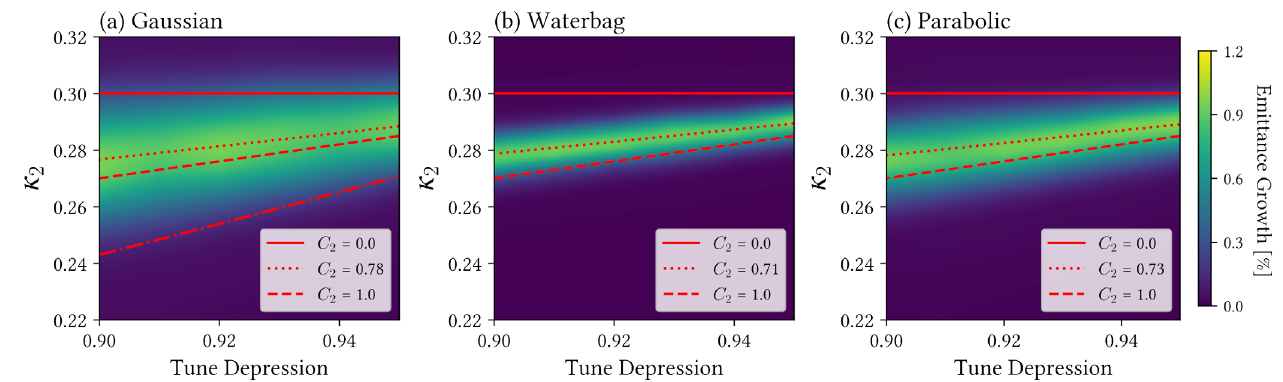
FIG. 12. Emittance-growth chart obtained from W ARP simulations with the quadrupole driving perturbation on. Three different types of initial particle distributions, i.e., (a) Gaussian, (b) waterbag, and (c) parabolic, are considered, all of which are well matched to the sinusoidal focusing potential. The Gaussian tail has been truncated by one percent in four-dimensional phase space. The bare betatron tunes are fixed at ν 0 x ¼ ν 0 y ¼ 0 . 15 . The linear perturbation is applied to excite the quadrupole ( m ¼ 2 ) resonance. The perturbation amplitude is set at 0.2% of the focusing field ’ s. The solid and dashed lines correspond to the cases where C 2 ¼ 0 (single-particle resonance) and C 2 ¼ 1 . The dotted line is the location of the stop-band peak fitted by Eq. (14) with C 2 ¼ 0 . 78 for Gaussian, C 2 ¼ 0 . 71 for waterbag, and C 2 ¼ 0 . 73 for parabolic. The dash-dotted line in the left panel indicates the incoherent resonance line for a particle with the maximum tune